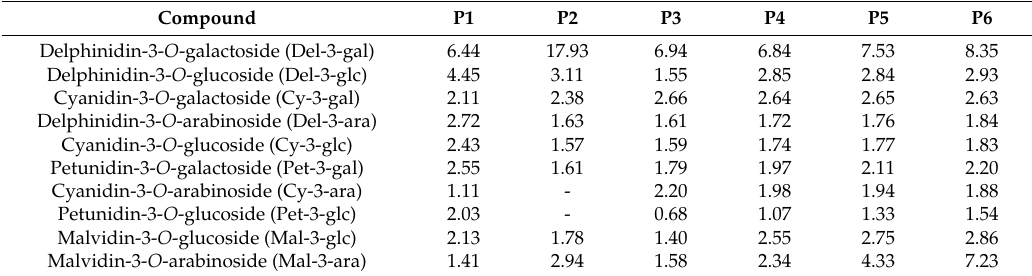
Table 1. Separation resolutions of the compounds under di ff erent elution